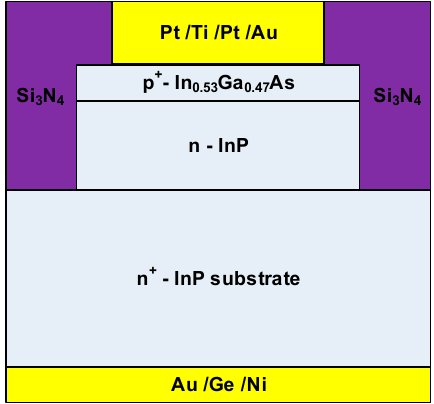
/ In 0.53 Ga 0.47 As